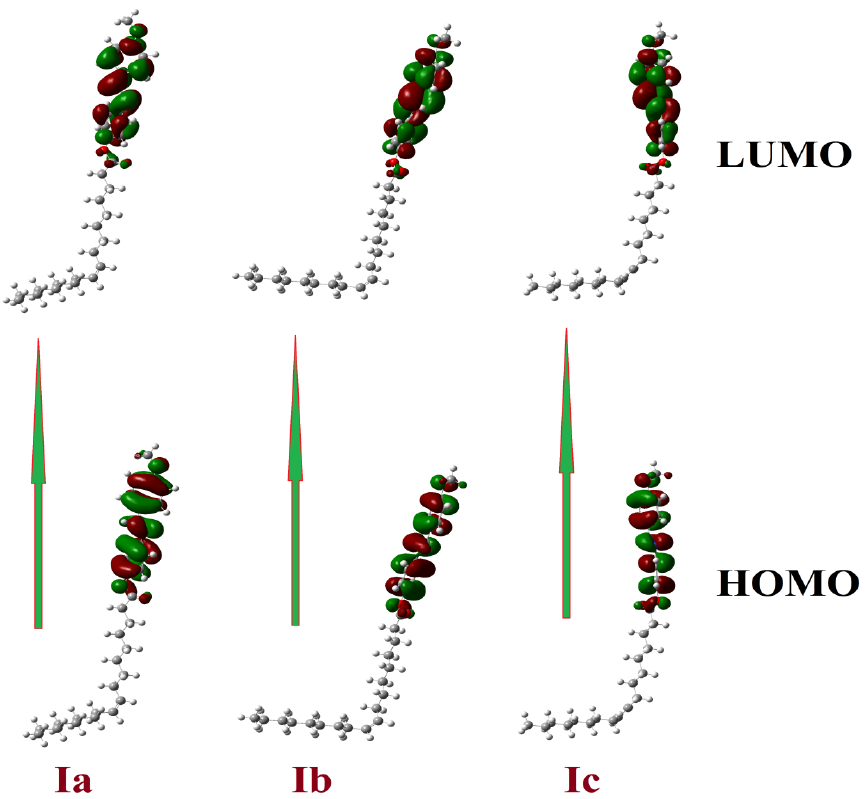
Figure 15. The estimated plots for frontier molecular orbitals of all isomers Ia – c . Table 5. Frontier molecular orbital (FMO) energies a.u., and softness of all isomers ( Ia – c).